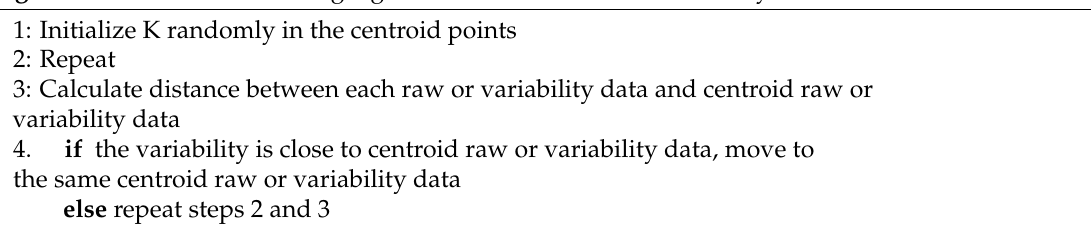
Algorithm 2 K-means clustering algorithm for raw data and variability